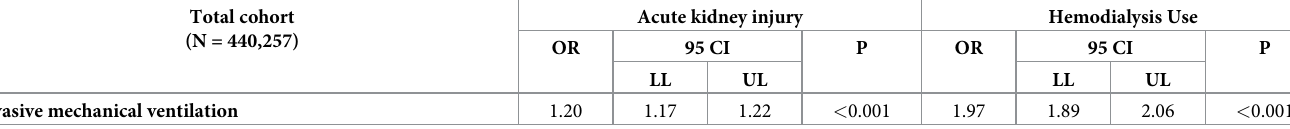
Table B. Multivariable regression for in-hospital mortality in